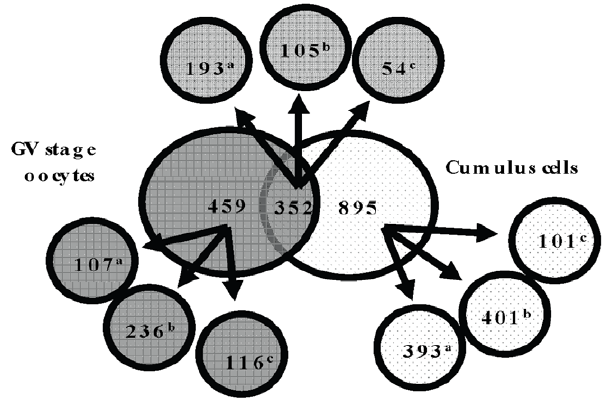
Figure 1. Comparison of proteins identified in germinal vesicle (GV) oocytes and cumulus cells. Distribution of predicted, known, and hypothetical proteins in GV oocytes and cumulus cells is shown. Superscript a, b and c=known, predicted and hypothetical proteins, respectively.